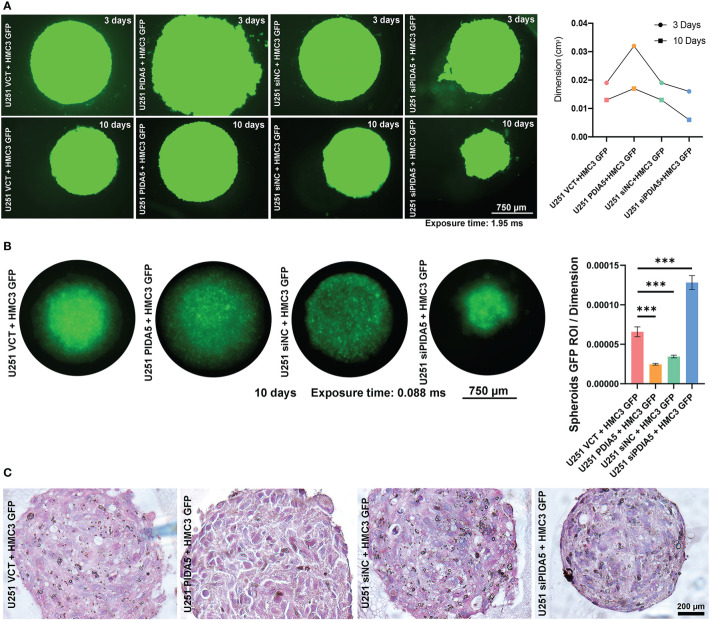
PDIA5 high expression tumor cells exhausted immune cells (HMC3) activation. (A) PDIA5 relative U251 lines were co-cultured with HMC3 GFP in organoids medium and monitored and quantified at 3/10 days-post droplets implantation (exposure time: 1.95 ms). (B) GFP ROI per dimension measurements valued the viabilities of HMC3 in each co-culturing (exposure time: 0.888 ms). (C) HE stained co-cultured organoids demonstrated cell types. Note: figure panel pairs in (A–C) represent images captured at differing magnifications; magnification scale bars: panel (A, B)
4×amplification: 750 µm; panel (C)
10×amplification: 200 µm. ***P <.001.